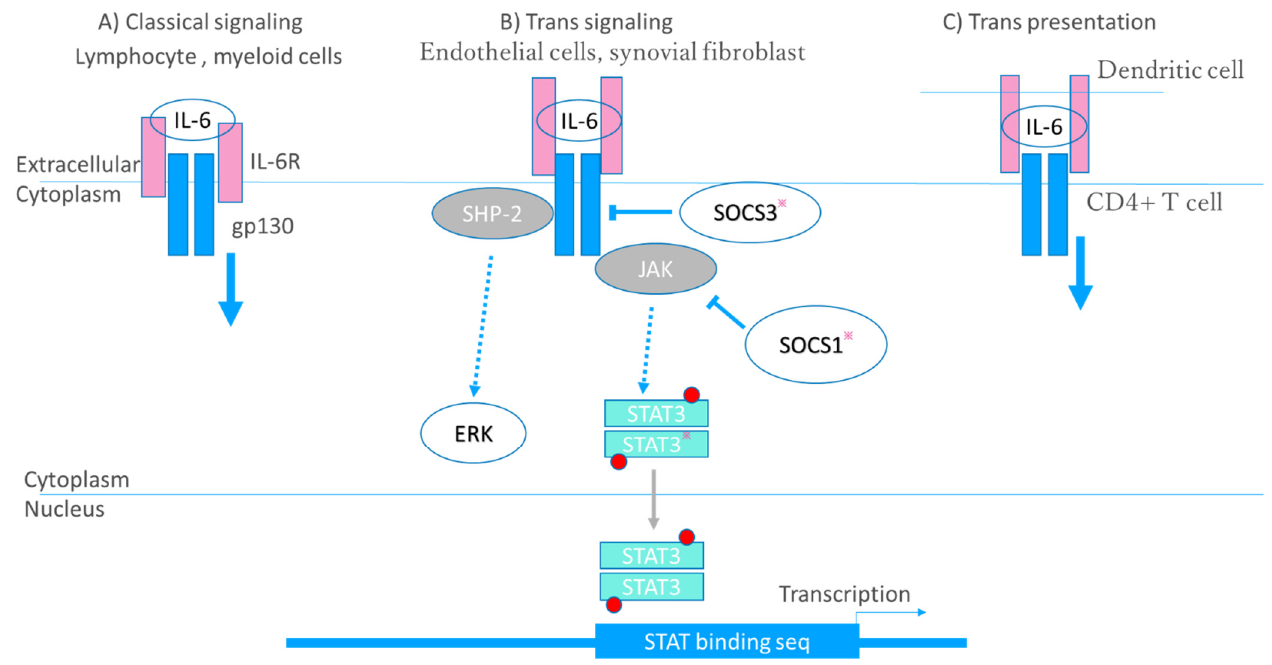
Figure 3. Signaling cascade of IL-6. Interleukin (IL)-6 activates a signal cascade via three modes of receptor–ligand interaction. ( A ) Classical signaling. IL-6 binds to its receptor, IL-6R α , then activates an intracellular signal transduction pathway via glycoprotein130 (gp130) dimerization. ( B ) Trans-signaling. IL-6R also exists as a secreted form (sIL-6R α ). sIL-6R α binds to IL-6, and the resulting complex binds to gp130 on endothelial cells or synovial fibroblasts. ( C ) Trans presentation. Circulating IL-6 binds to IL-6R α expressed on dendritic cells, and then the IL-6/IL-6R α complex binds to gp130 expressed on CD4 + T cells. The IL-6/IL-6R α complex binds gp130 to form a gp130 homodimer, thus activating Janus kinase (JAK). JAK activates the signal transducer and activator of transcription (STAT) family transcription factors, mainly STAT3, and src homology region 2 domain-containing phosphatase 2 (SHP-2). JAK phosphorylates STAT3 to form a homodimer, which then translocates to the nucleus where it functions as a transcription factor. JAK also activates the extracellular signal-regulated kinase (ERK)/mitogen-activated protein kinase (MAPK) pathway through SHP-2. STAT3 induces suppressor of cytokine signaling1 (SOCS1) and SOCS3; SOCS1 inhibits JAK directly, and SOCS3 inhibits gp130. Promising therapeutic targets are indicated with an asterisk. In addition to a JAK inhibitor, an inhibitor of STAT, and a substrate that would regulate the level of SOCS expression could be therapeutic targets.